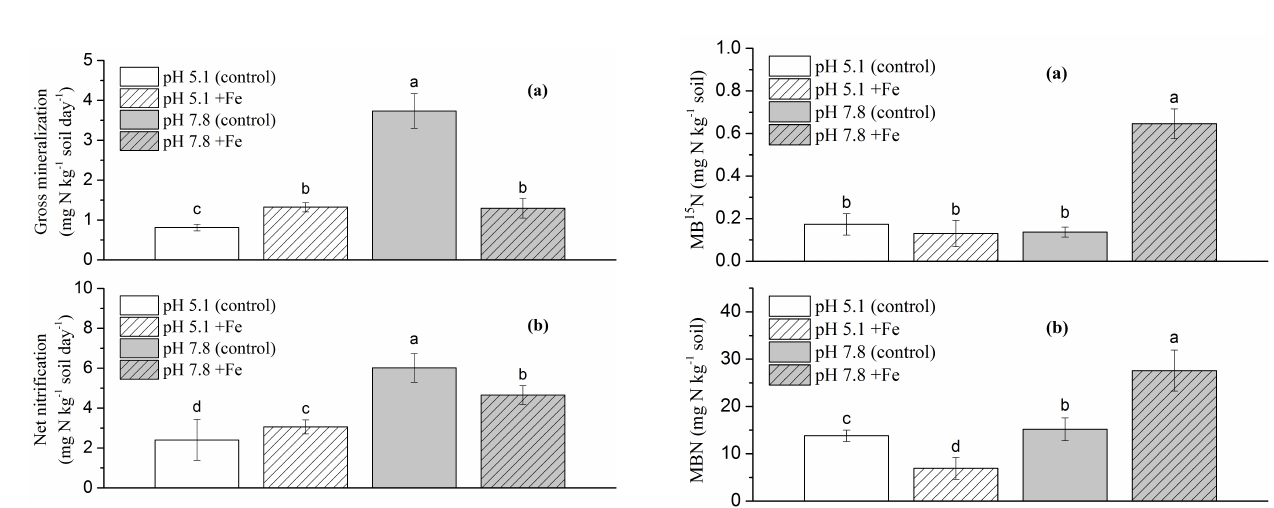
Figure 4. Effects of Fe oxide on MB 15 N (a) and MBN (b) pools during 6 days with ( 15 NH 4 ) 2 SO 4 treatment incubation at 28 ◦ C with soil moisture at 100% WHC. Error bars represent standard deviations; n = 3. The different letters above the columns indicate a significant difference ( P